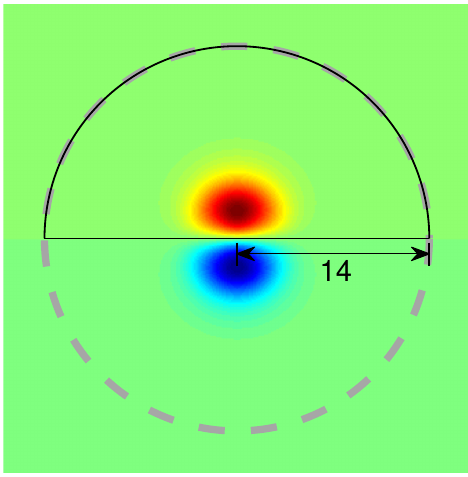
Figure 5. Circular disk region used to evaluate E c and Q c and semi-circular disk region to evaluate energy E and charge Q . The radius of the semi-circle is 14 , in units of 1 /m . (In 3D, we will use s s a corresponding semi-ball with radius of